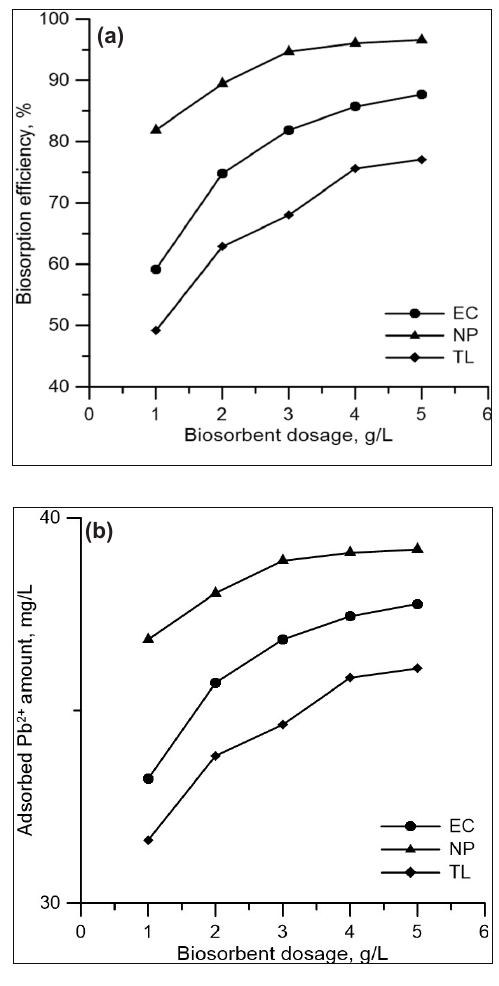
Fig. 2. Influence of pH on biosorption efficiency Fig. 3. Influence of sorbent dosage (a) on biosorption efficiency and (b) on adsorbed